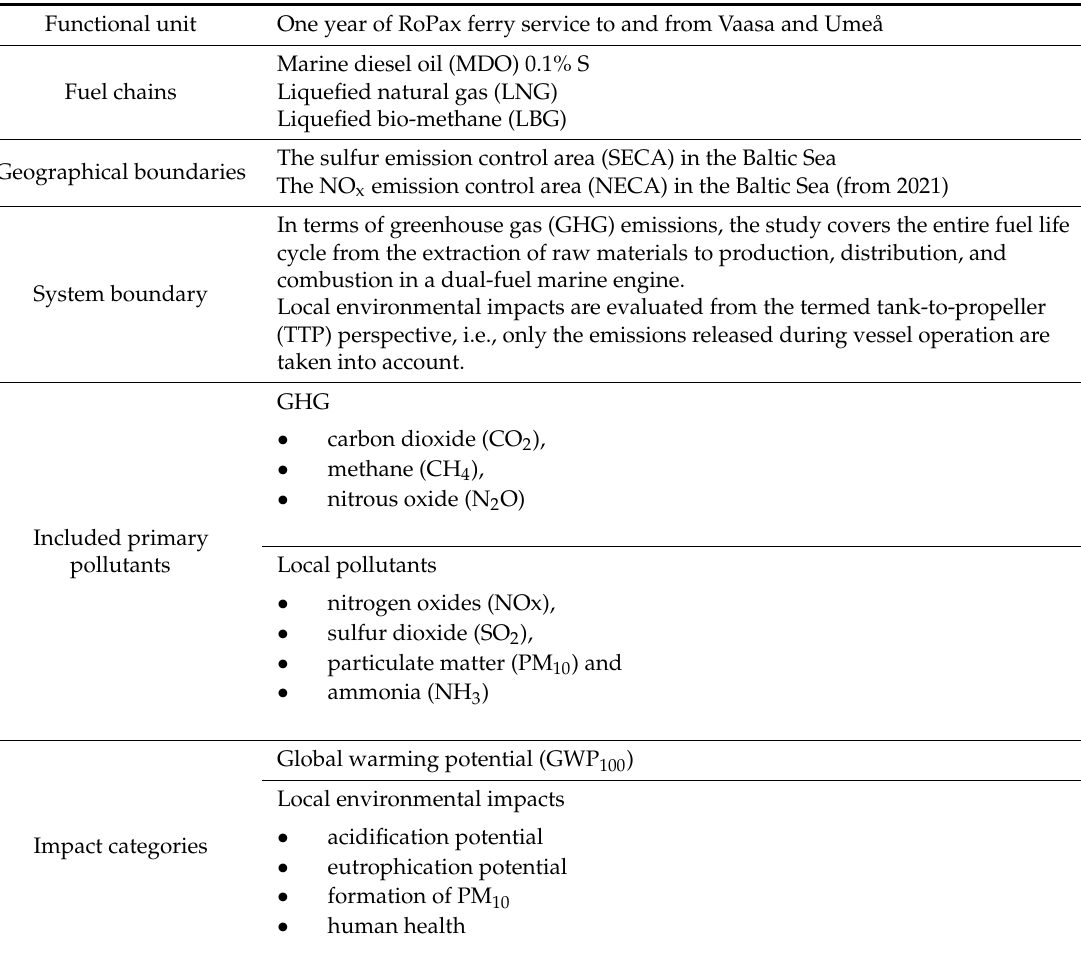
Table 2. Modelling choices of the study. Reproduced from [26], VTT Technical Research Centre of Finland: